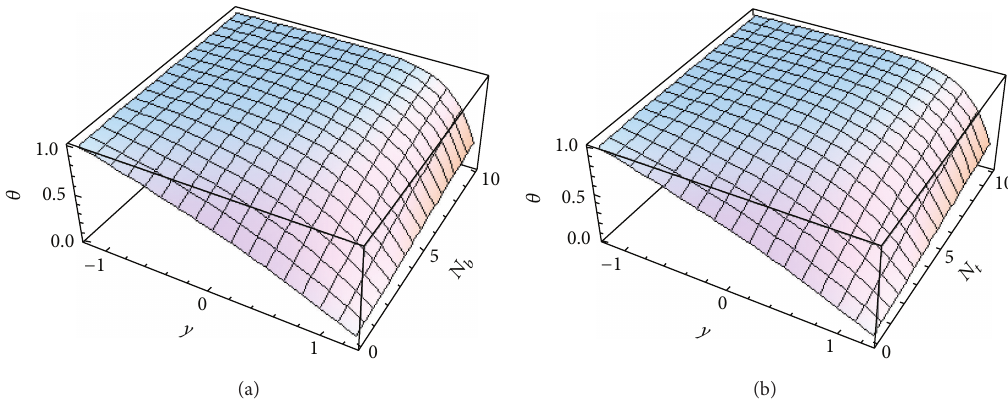
Figure 5: Variation of temperature profile at different values of (a) 𝑁 𝑏 for 𝑁 𝑡 = 0.8 and (b) 𝑁 𝑡 for 𝑁 𝑏 = 0.8 ; both cases when 𝑑 = 1 , 𝑎 = 0.5 , = 0.1 . 𝑏 = 0.5 , 𝜙 = 0.2 , 𝑥 = 1 , 𝛾 = 0.1 , and 𝛾 1